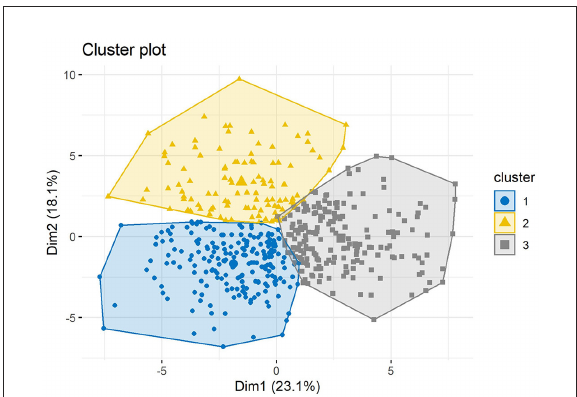
FIGURE7 Projection of scatter plot for three clusters divided by cluster analysis on principal components. The horizontal axis represents the first principal component and the vertical axis represents the second principal component.